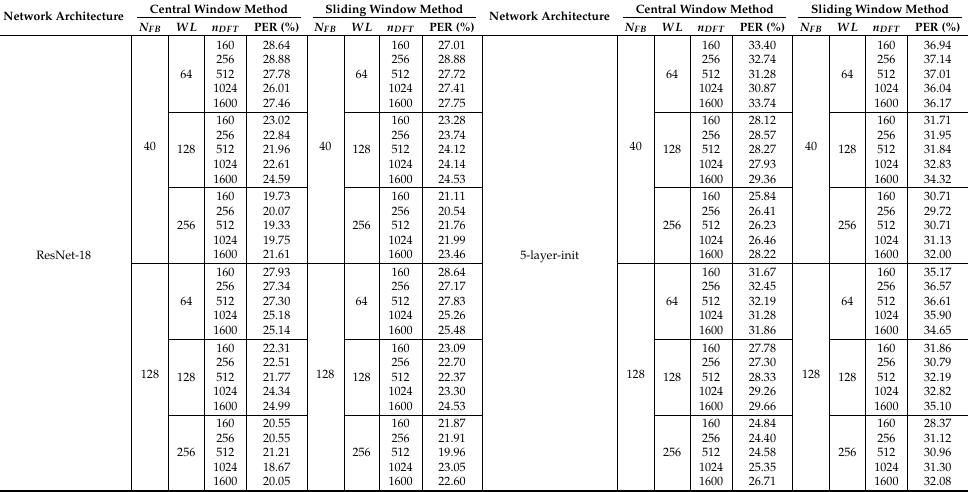
Table 3. Phoneme Error Rates (PER) calculated for different tested architectures and all combinations of speech preprocessing parameters on the TIMIT core test